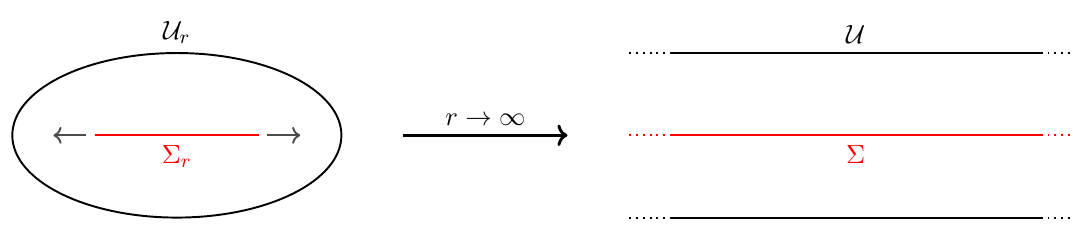
Figure 4 . For (cid:6) with an asymptotic boundary, the symplectic structure is obtained by integrating over @U r , and then taking the limit as U r grows to contain the entirety of (cid:6). It is important to recognise that an asymptotic boundary really only makes sense as the limit of a (cid:12)nite boundary as some parameter goes to in(cid:12)nity. For example, in